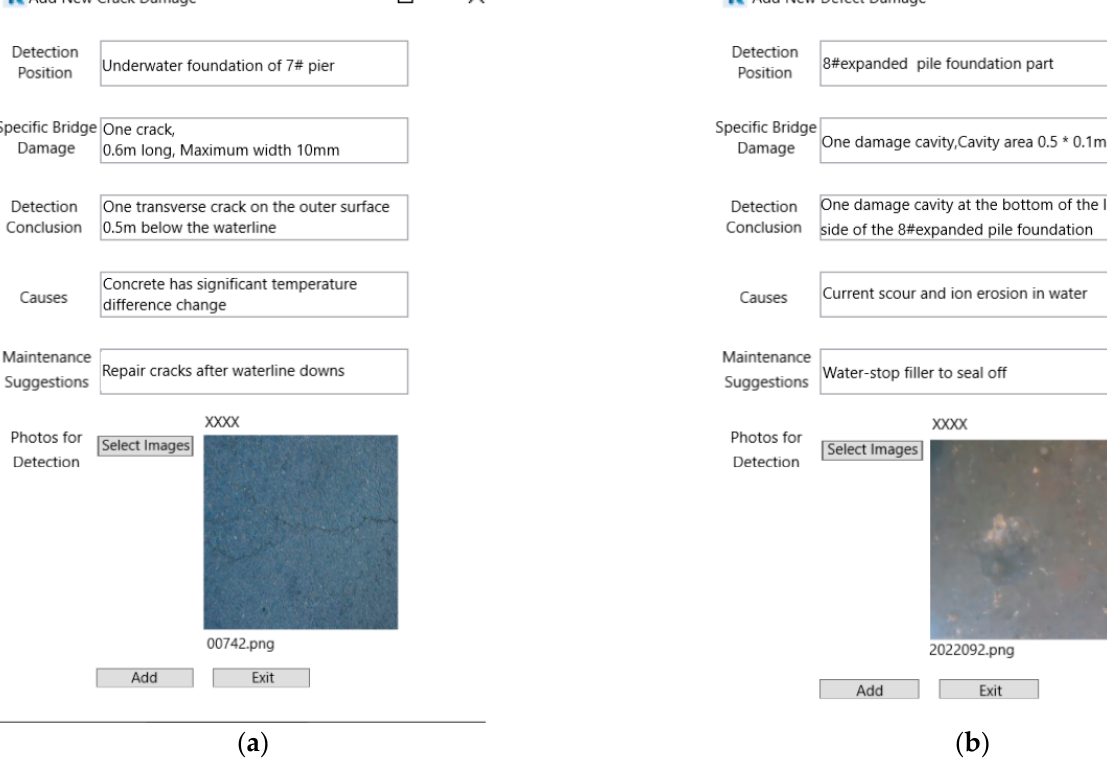
Figure 15. Added Disease Information. ( a ) Add new crack damage. ( b ) Add new defect damage.